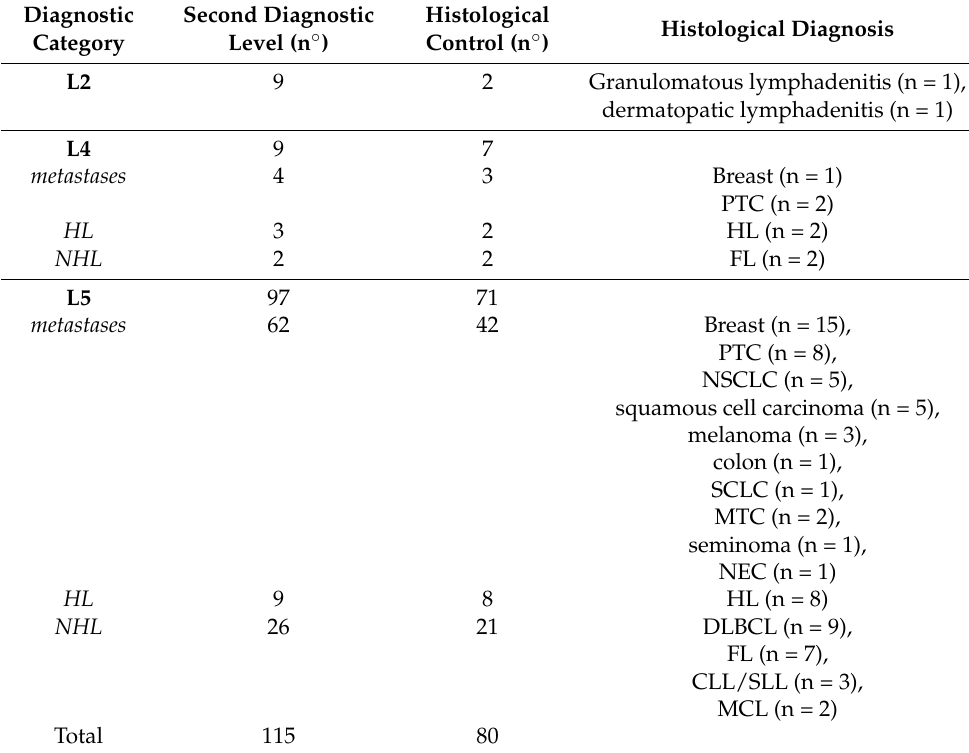
Table 2. Second diagnostic level and corresponding histological control.